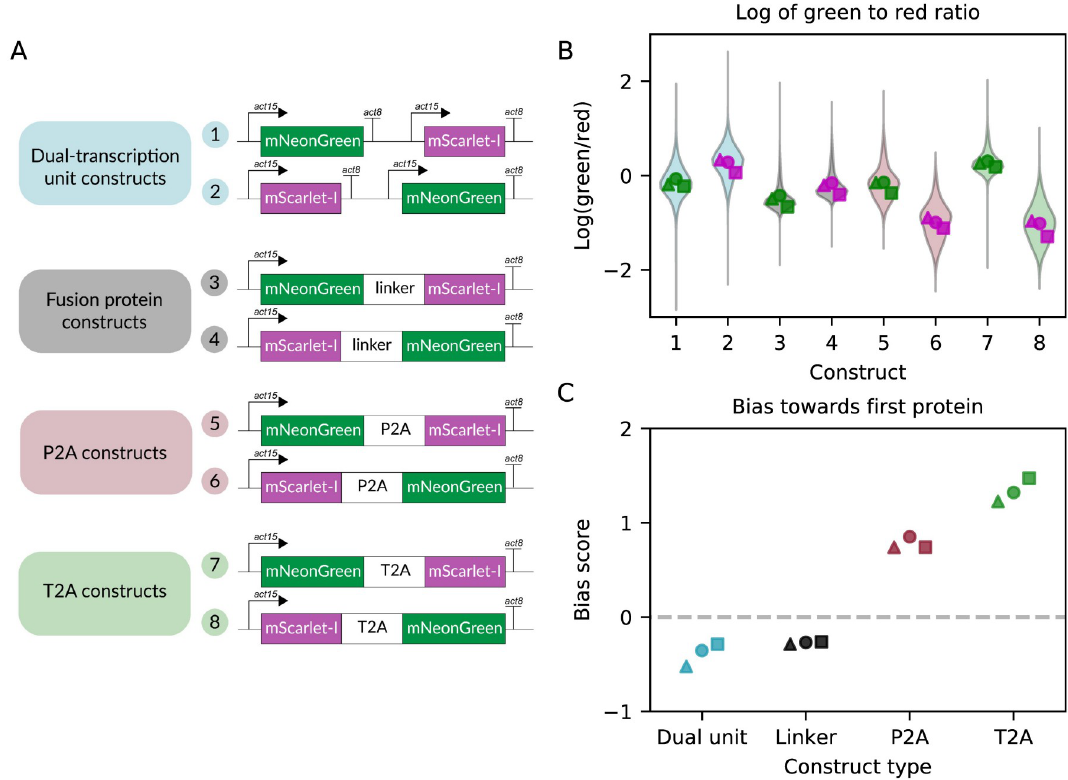
Fig 2. Order effects are milder for P2A compared to T2A. A: Constructs transfected into AX4 D. discoideum cells. In dual- transcriptional unit constructs, two fluorescent reporters in separate transcriptional units are directly adjacent to each other on the same plasmid. The other construct types co-express both reporters from a single transcriptional unit, joined by either a linker or a 2A peptide sequence. Each transcriptional unit was assembled with an actin15 promoter and an actin8 terminator. B: Natural logarithm of green to red fluorescence ratio calculated for single cells for each construct. The violin plot represents the aggregate single-cell data from three independent transfections, while each individual point is the mean expression level of one transfection. Data below the 0.01th and the 99.99th percentile were excluded from plotting but retained for downstream analysis. Markers filled with green correspond to mNeonGreen-first constructs, and markers filled with magenta correspond to mScarlet-I-first constructs. C: Bias score calculated for each construct type. The bias score is the difference between the mean log(green/red) expression ratio of the mNeonGreen-first construct and that of the mScarlet-I-first construct. In the absence of gene order bias, this score should be zero (dashed line). Positive numbers represent a bias towards the first protein while negative numbers represent a bias towards the second protein. Each marker shape indicates an independent experiment ( 4 : replicate 1, ◯ : replicate 2, □ : replicate 3).